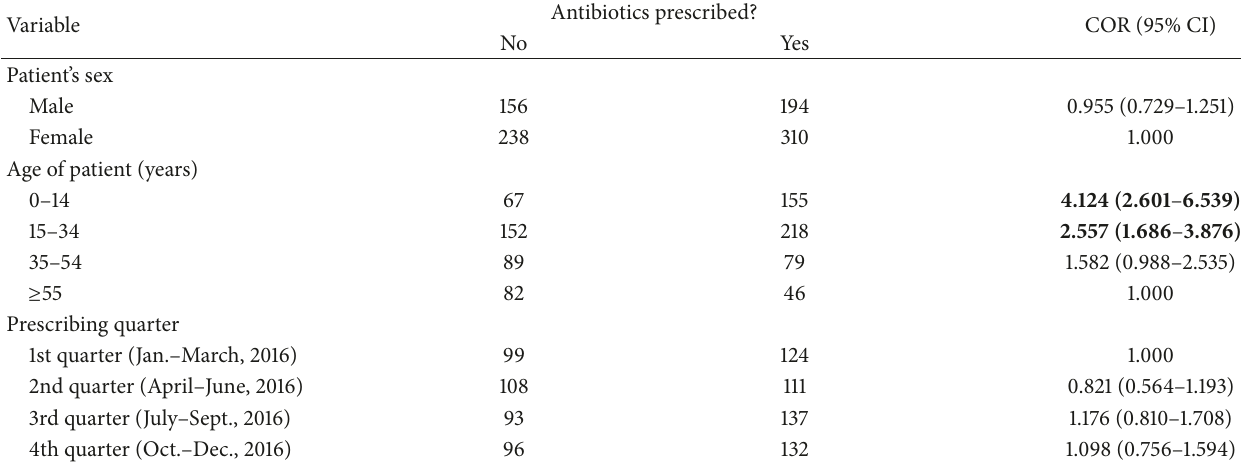
Table 5: Bivariate logistic regression of factors associated with antibiotics prescribing at health centers in Addis Ababa, January